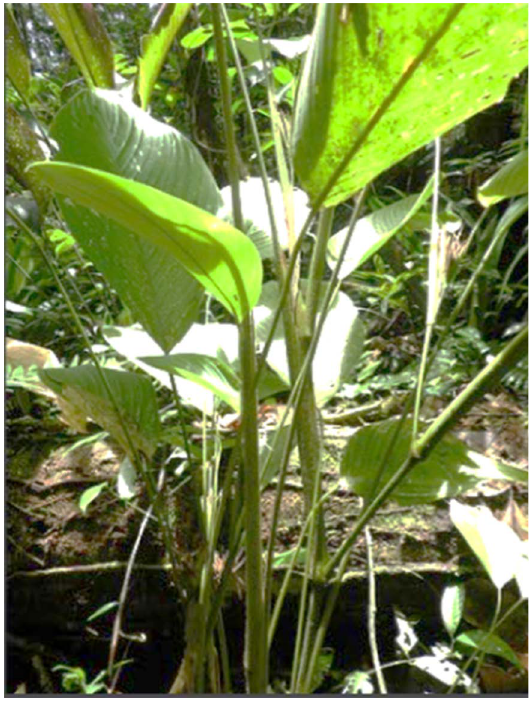
Figure 1. The guaruman plant.